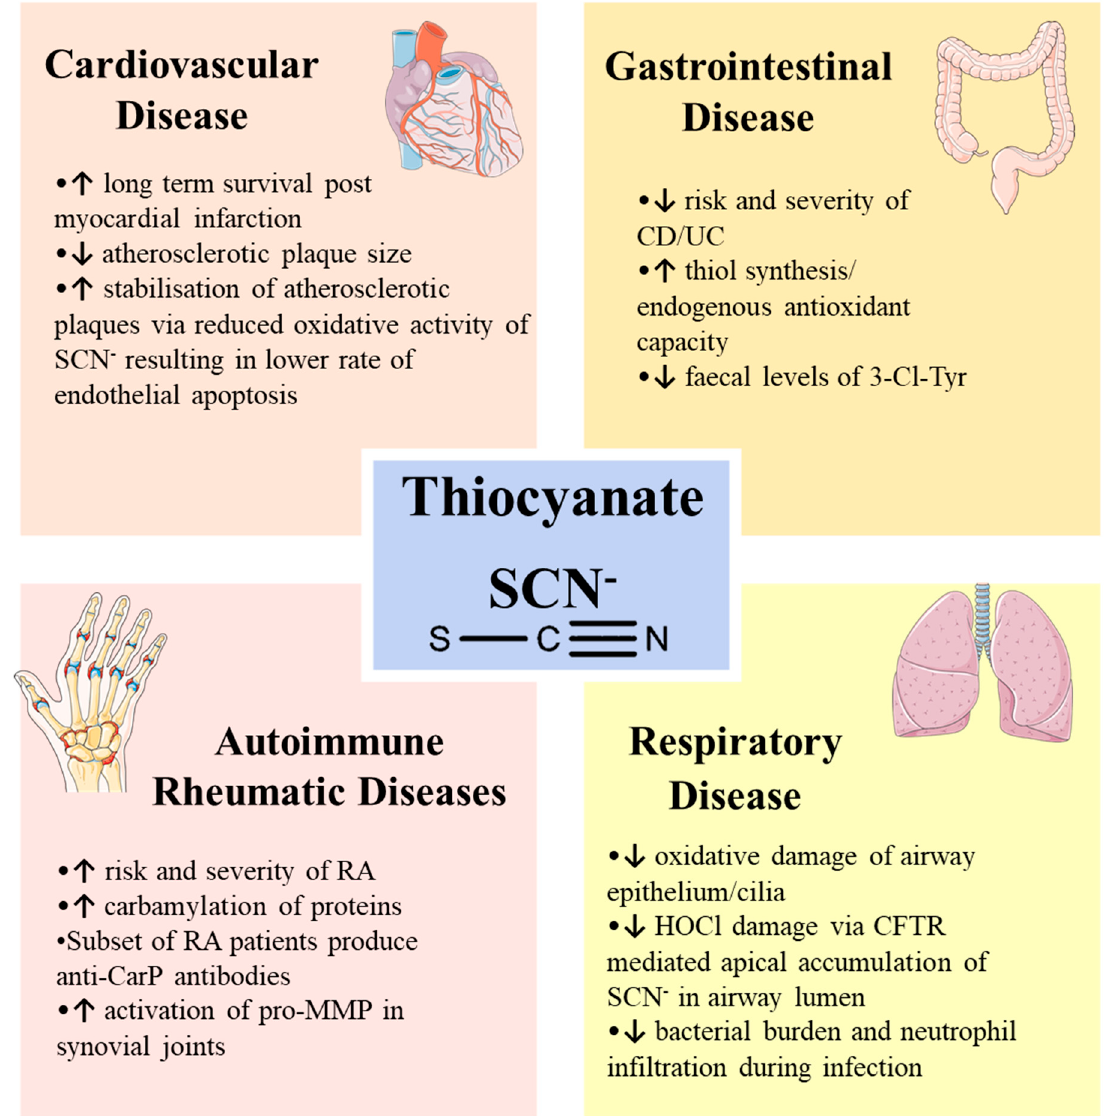
Figure 4. Schematic overview of SCN − in various human diseases.